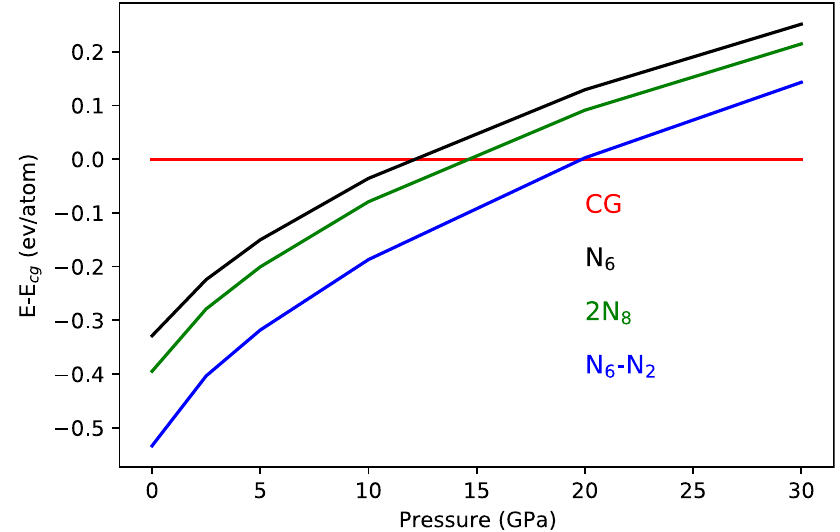
Figure 3. Enthalpy shift from cg-PN of the molecular crystals N 6 –N 2 , the 2N 8 from the work of